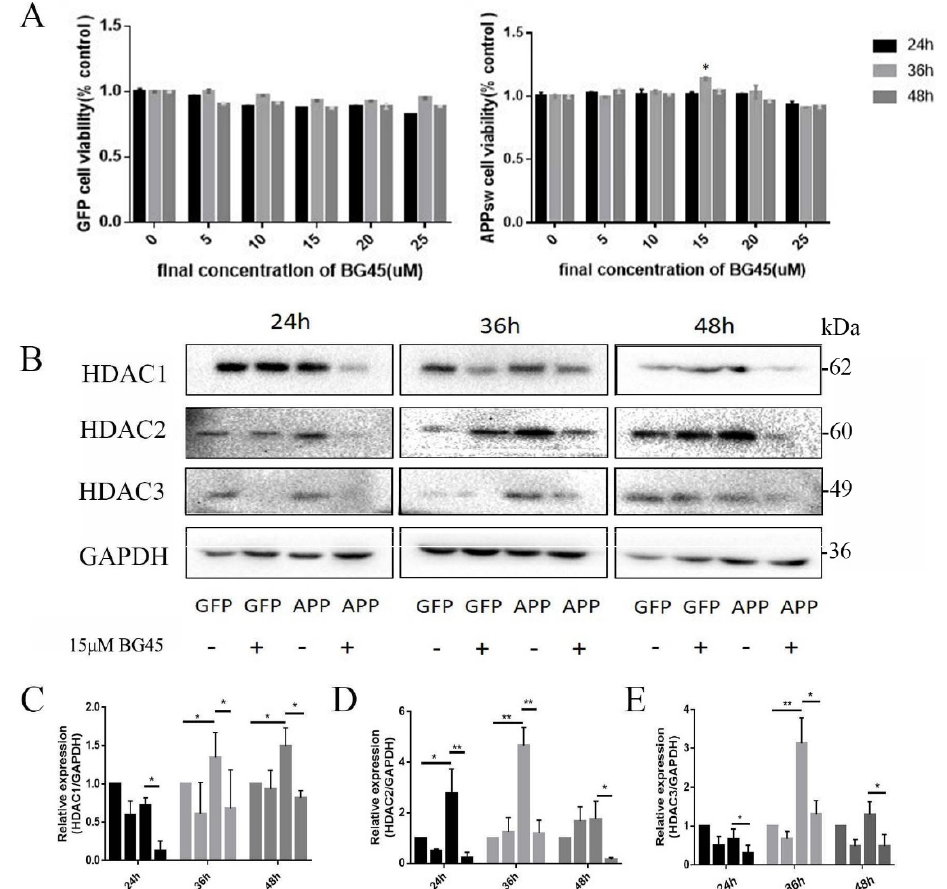
Figure 3. The effects of BG45 on Class I HDACs (HDAC1, 2, and 3). ( A ) The effect of BG45 on GFP- positive and APPsw-positive cell viability. ( B ) Immunoblot analysis of HDAC1, 2, and 3 levels in GFP- and APPsw-positive cells treated with vehicle or BG45 (15 µ M) for different periods. ( C ) Quantification of HDAC1 levels. ( D ) Quantification of HDAC2 levels. ( E ) Quantification of HDAC3 levels. Significant differences were determined using Student’s t -test. All values are presented as the means ± SD from three independent experiments. * p < 0.05, ** p < 0.01.